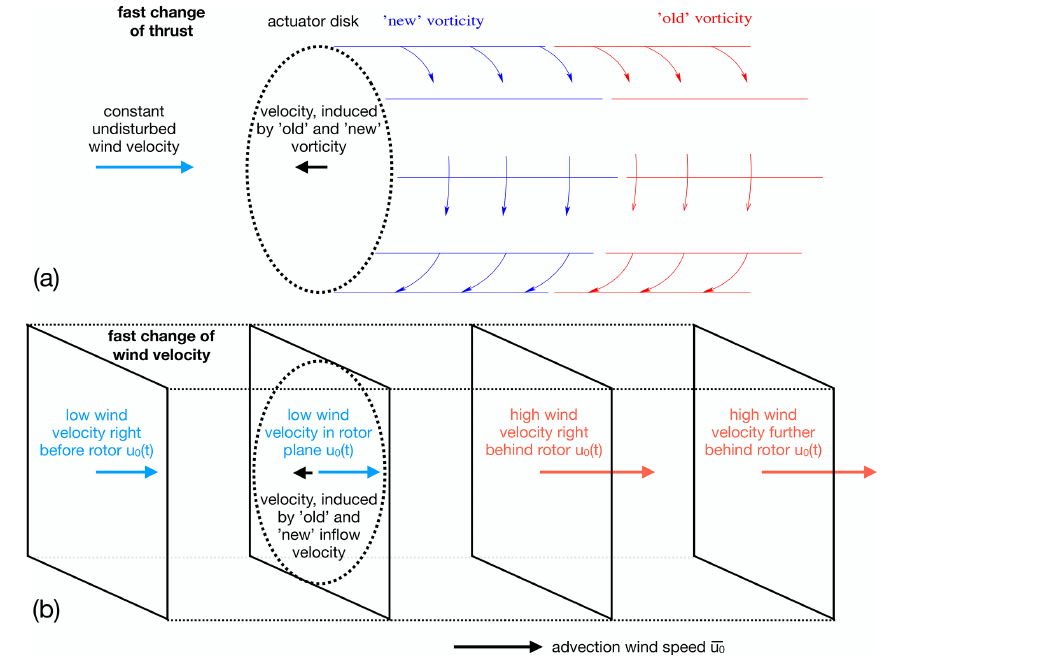
Figure 6. Wake with mixed vorticity as a result of a fast change in thrust (modified from Schepers, 2007) (a) and simplified turbulent box with coherent gust-like sudden drop in wind velocity (b)